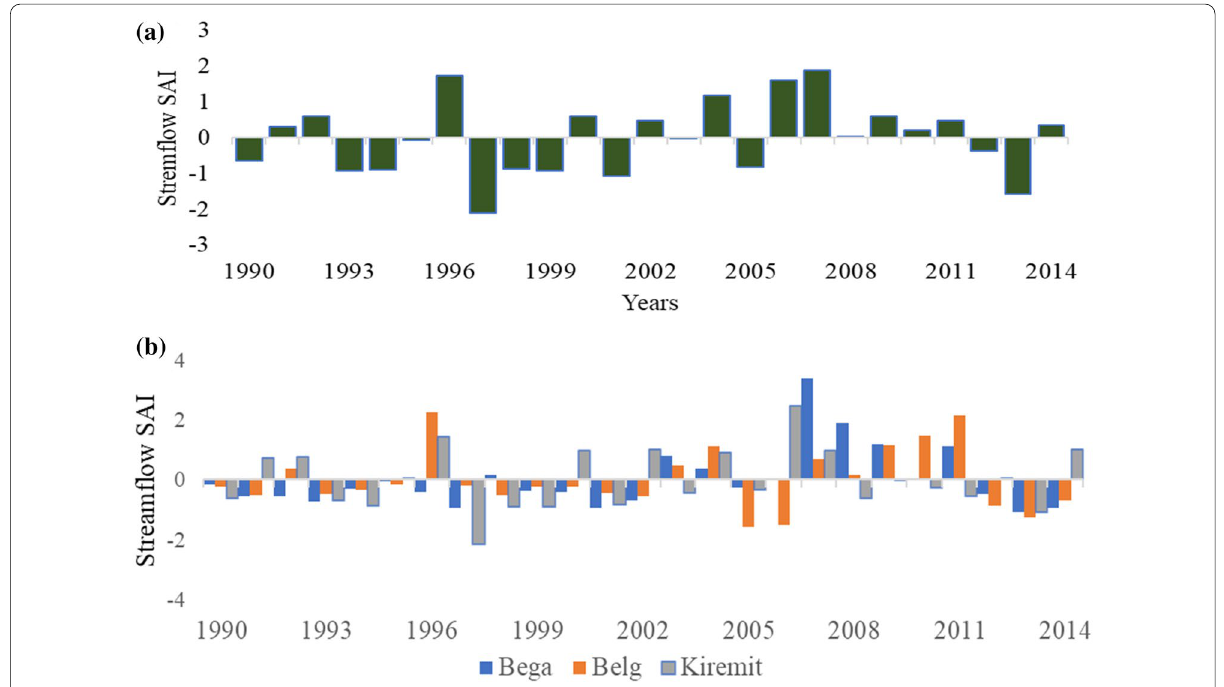
Fig. 16 Annual ( a ) and seasonal ( b ) stream flow standardized anomaly